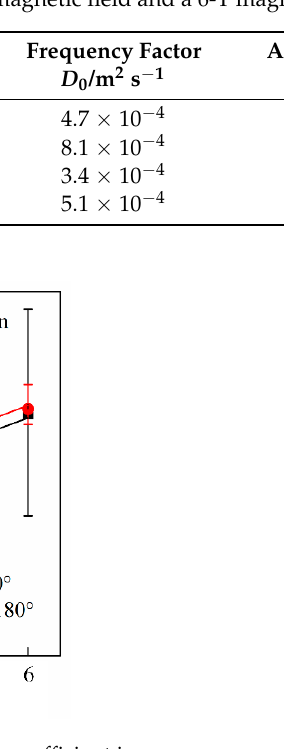
Figure 5. The linear dependence of cobalt diffusion coefficient in copper on magnetic field